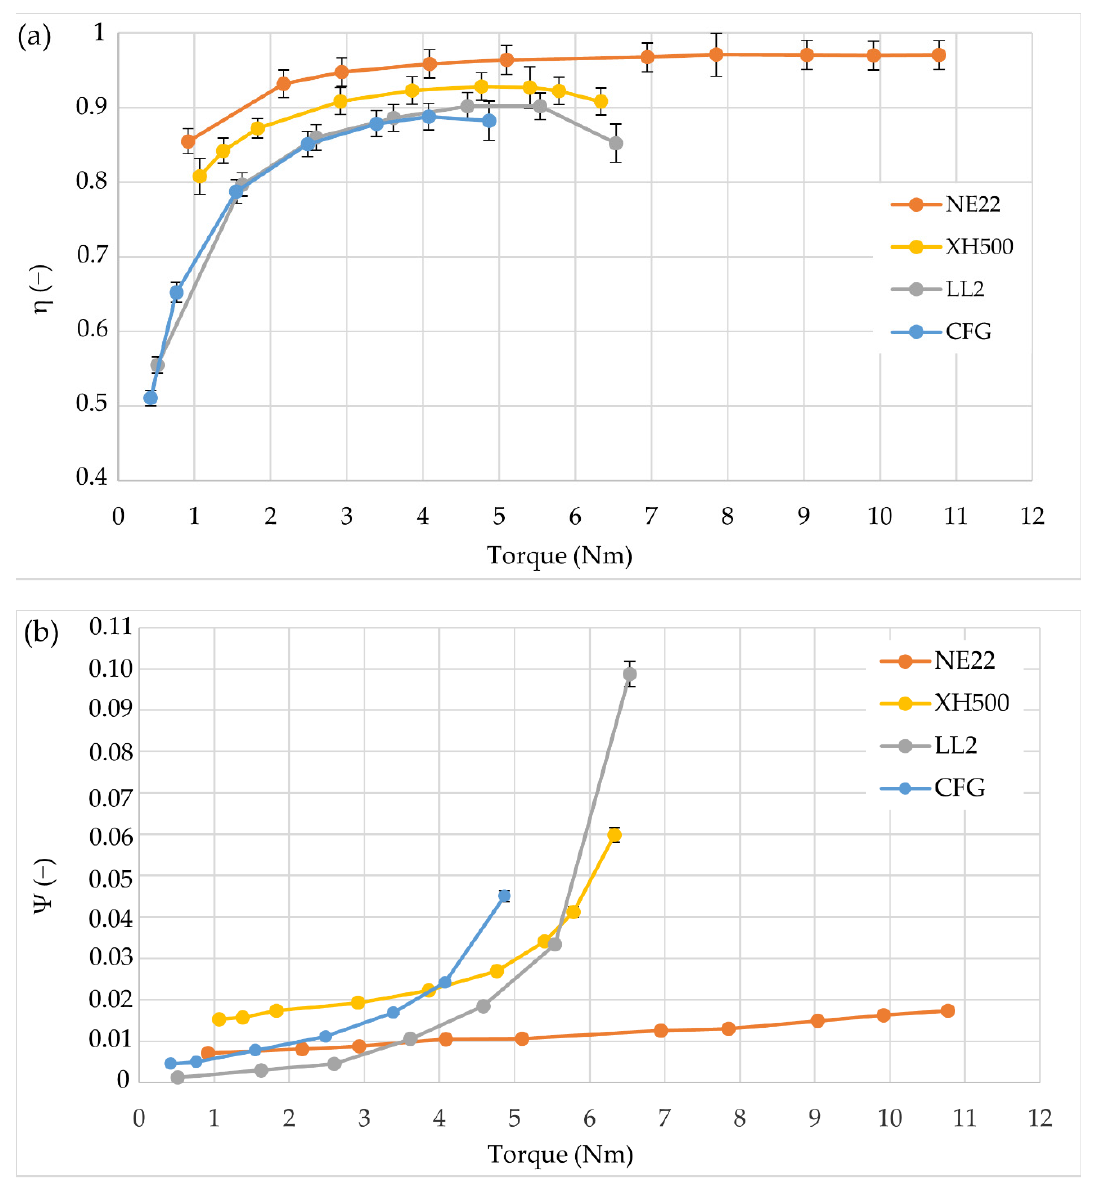
Figure 6. Variation characteristics of ( a ) efficiency as a function of torque at the idler shaft ( b ) belt slippage as a function of torque at the idler shaft for a speed of 500